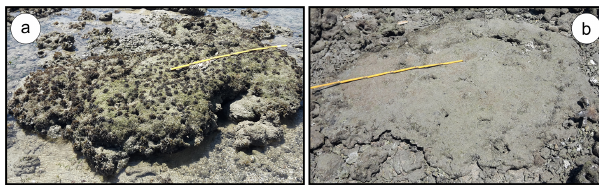
Figure 2. Examples of (a) non-eroded and (b) eroded fossil mi- croatoll at